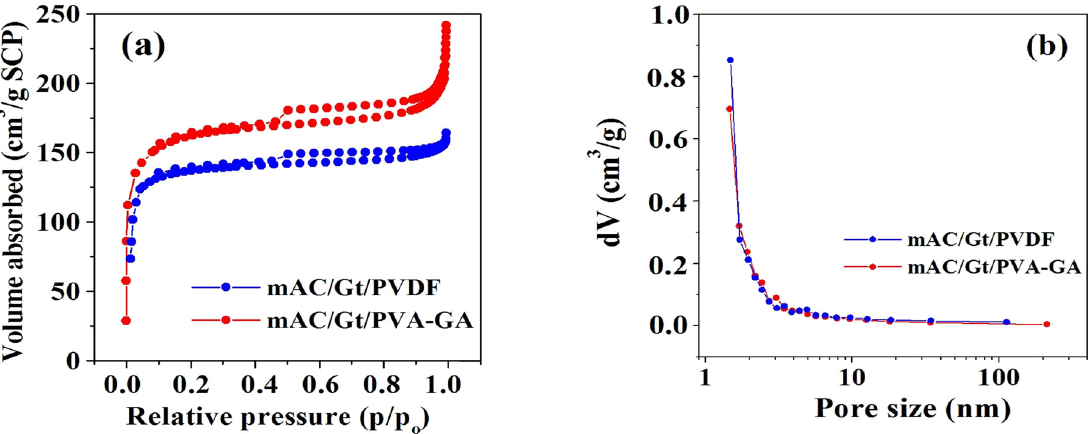
Figure A5: ( a ) Nitrogen adsorption – desorption isotherms and ( b ) pore size distribution of mAC/Gt/PVDF and mAC/Gt/PVA - GA.